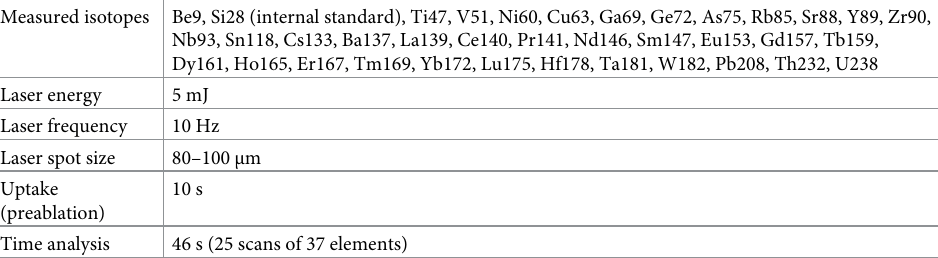
Table 2. Analytical LA-ICP-MS